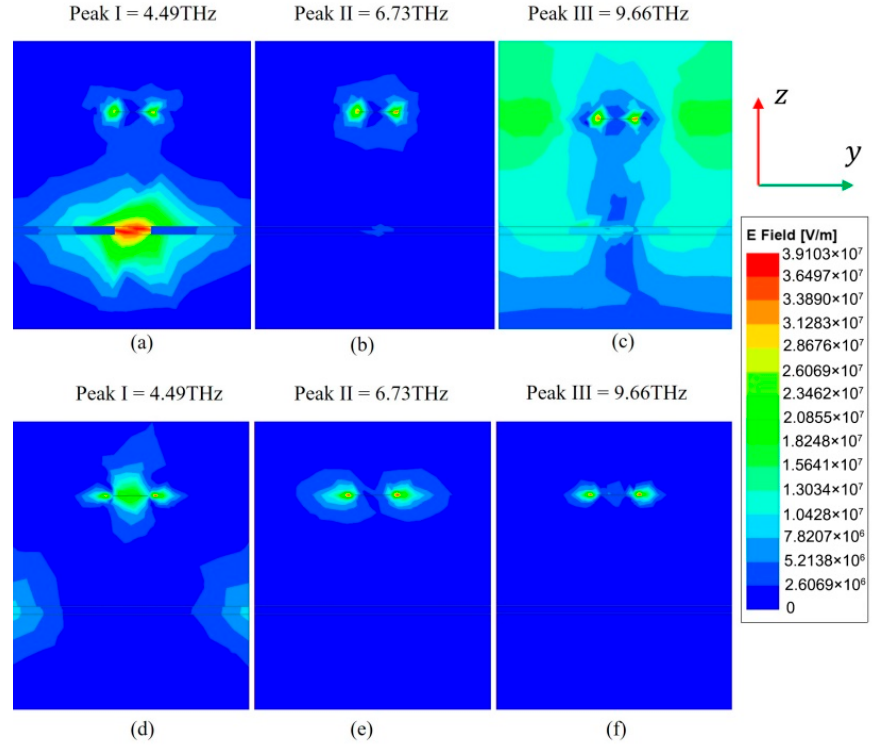
Figure 8. Absolute electric field distributions in the y-z planes to illustrate the energy localization at f = 4.49 THz, 6.73 THz, and 9.66 THz. ( a – c ) and ( d – f ) are the two adjacent faces in the structure.